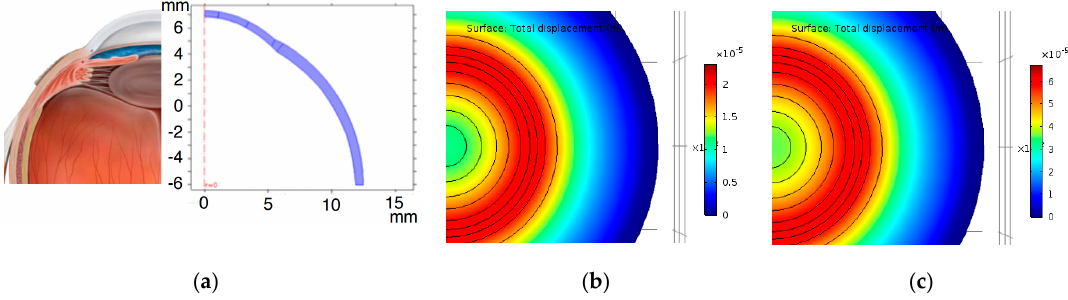
Figure 1. ( a ) 2D axisymmetric shape for 3D fibrous layer of the eye (unit of length is mm); ( b ) Simulated total displacements for Δ IOP = 5 mmHg; ( c ) for Δ IOP = 15 mmHg.